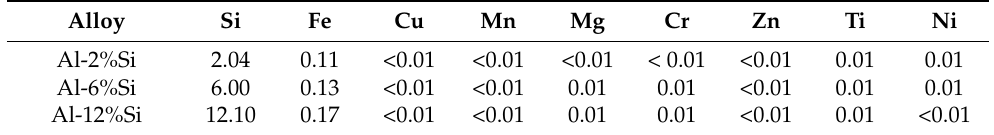
Table 1. Chemical composition of Al-Si alloys (mass%).